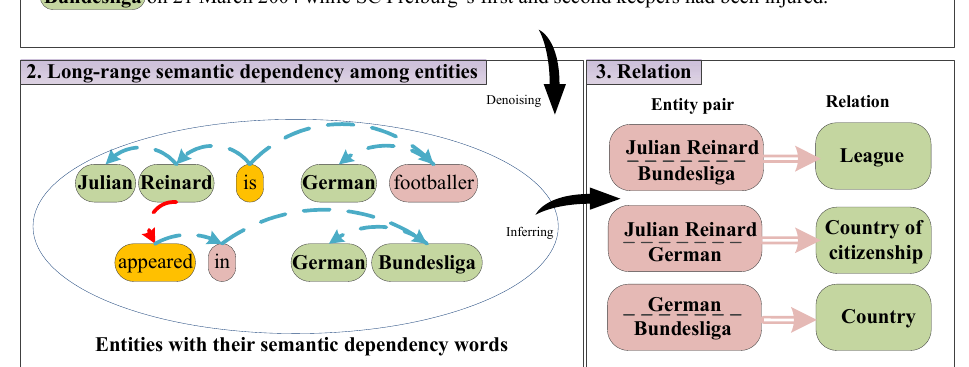
Fig. 1 Example of discovering a long-range semantic dependency among entities in a graph manner. Figure 1 presents three cards, in which Card 1 shows a document instance and its entities, Card 2 picks up minimal evidence (subgraph) along the syntax and discourse relation (blue or red line) to build the long-range semantic dependency for various entities (i.e., Julian Reinard, German, and Bundesliga), and Card 3 indicates the relation between each entity